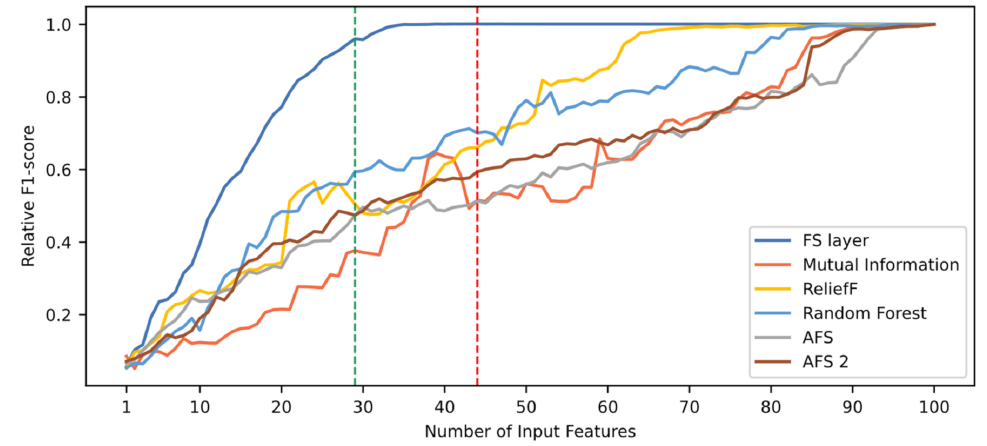
Figure 10. Comparison of relative F1-score based on six different rankings. The red and green dotted lines indicate the number of features needed when using the FS layer technique to reach maximum performance and a 95% of this value,